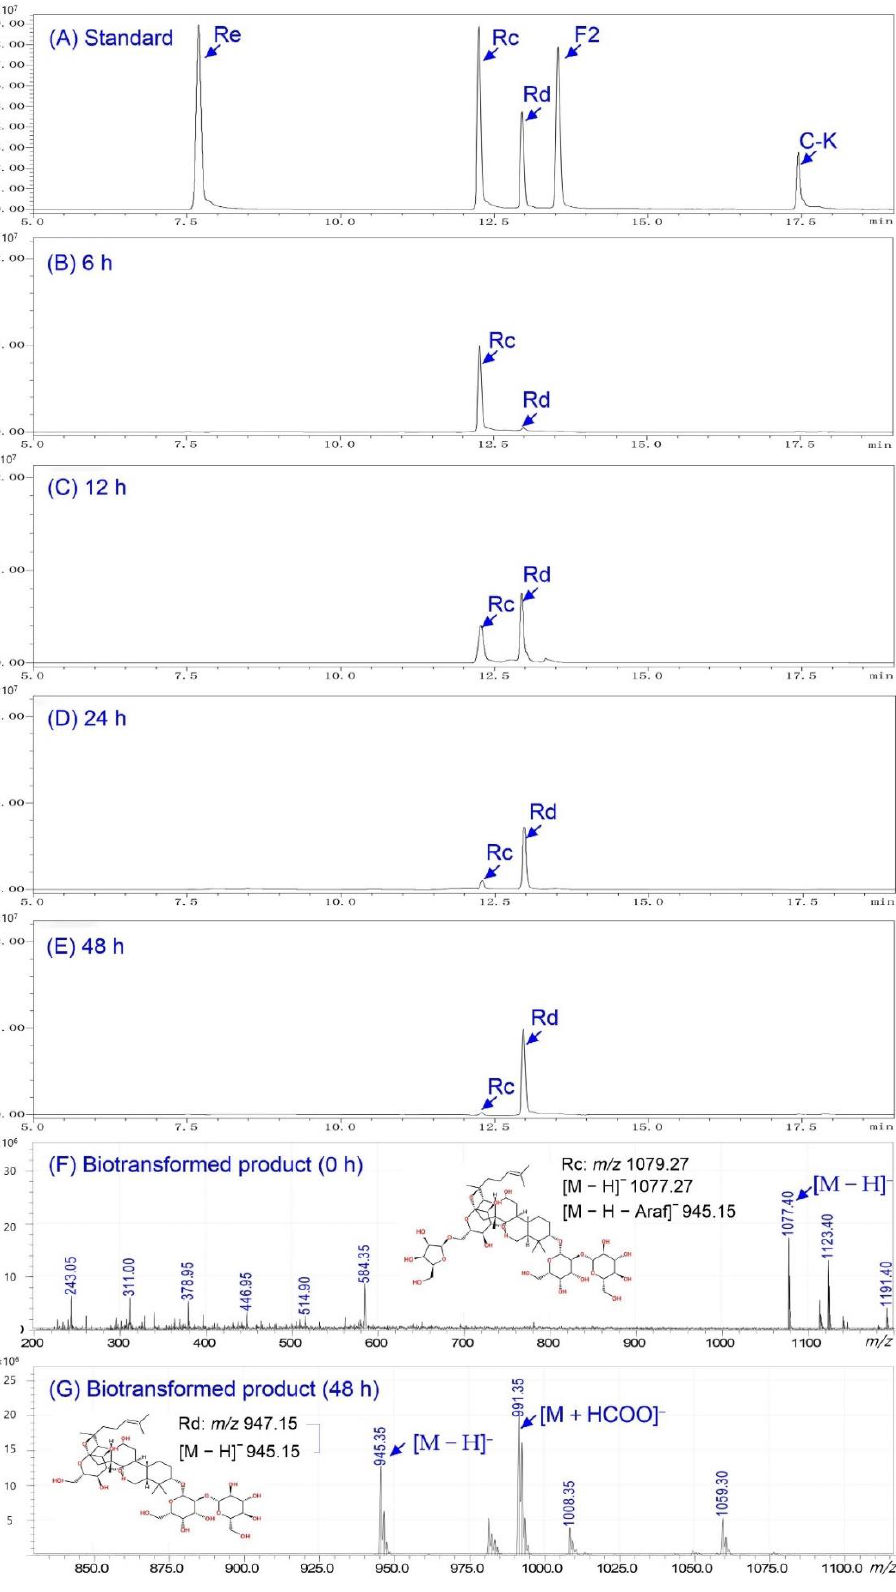
Figure 6. LC/ESI-MS analysis of metabolites of ginsenoside Rc hydrolysis by BsAbfA. ( A ) Standard ginsenoside Rc, Rd, Re, F 2 , and C-K. ( B – E ) The biotransformed products of ginsenoside Rc to Rd for 6, 12, 24, and 48 h respectively. ( F – G ) Extracted ion chromatograms obtained from the biotransformed products of Rc by BsAbfA for 0 h and 48 h, respectively.